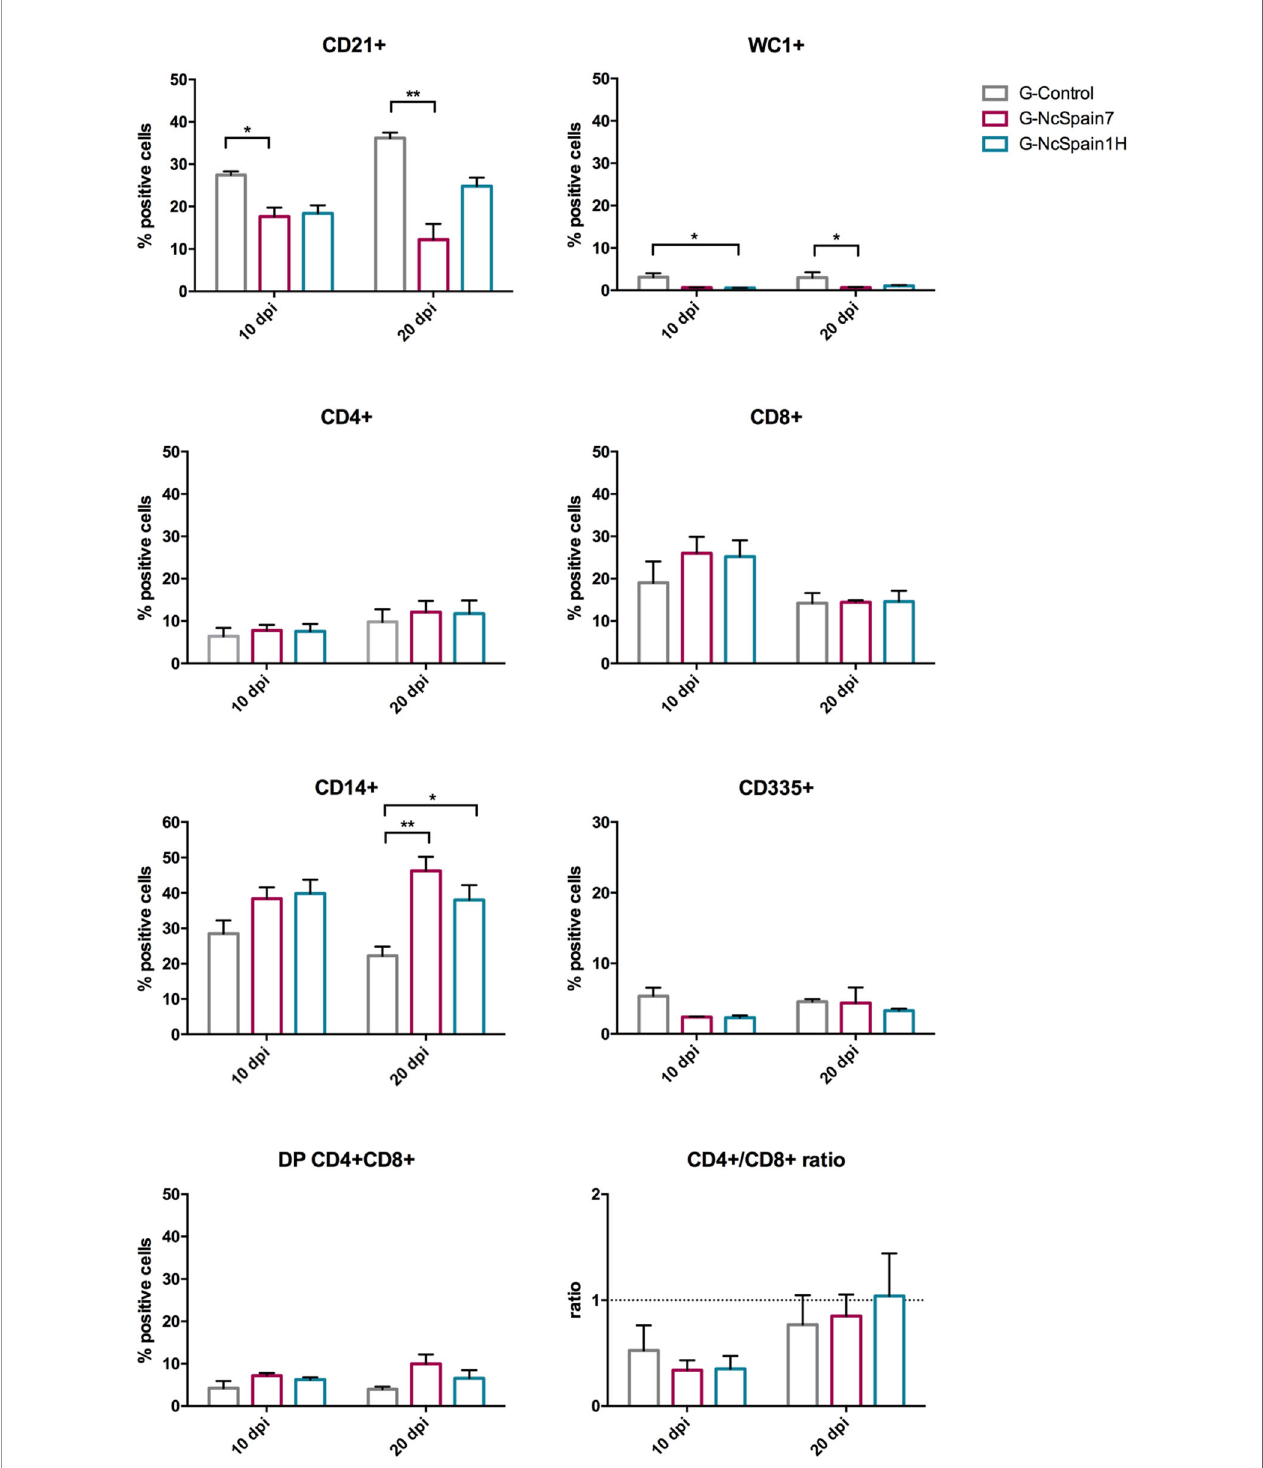
FIGURE 4 | Immune cell populations in the spleen offoetuses from Nc-Spain7 and Nc-Spain1H infected heifers at 10 and 20 dpi. Graphs indicate the relative percentage of cells positive for CD21, WC1, CD4, CD8, CD14 and CD335 surface markers, double positive (DP) CD4+CD8+ cells and CD4+/CD8+ ratio, in the population of immune cells obtained from the spleen offoetuses from uninfected heifers (G-Control) and heifers challenged with Nc-Spain7 (G-NcSpain7) and Nc- Spain1H (G-NcSpain1H) tachyzoites culled at 10 or 20 dpi. Theresults are represented as the mean+SD. Asterisks indicate signi fi cant differences. ** P <0.01, * P <0.05.